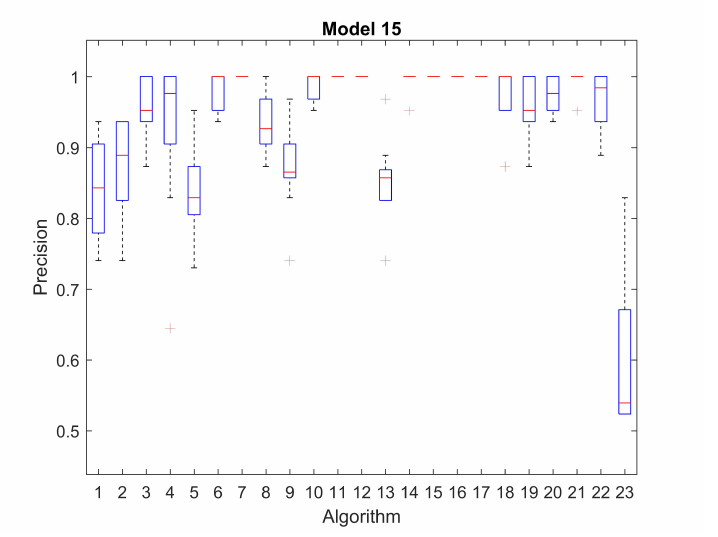
Figure A10. Precision of Model 15 for the different algorithms. The 23 algorithms are represented in the x -axis, and the accuracy is shown in the y